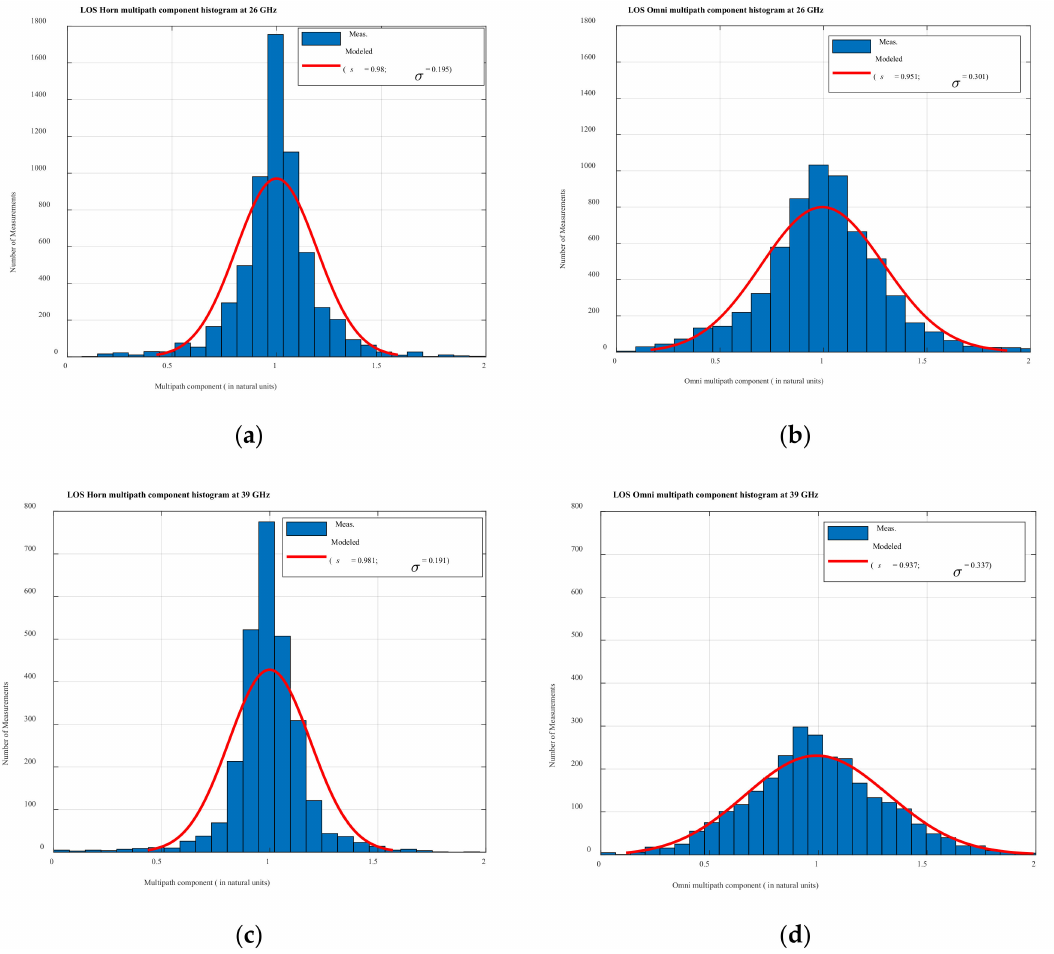
Figure 9. LOS measurements histogram and best-fit Ricean function for the Horn configuration at 26 GHz ( a ) and 39 GHz ( c ) and for the Omni configuration at 26 GHz ( b ) and 39 GHz ( d